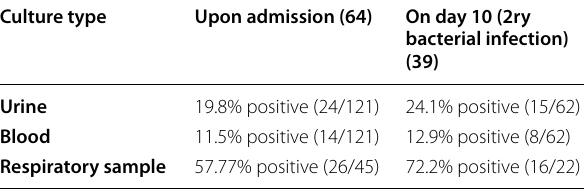
Table 5 Results of cultures of (blood, respiratory sample, urine) of patients upon admission to the ICU and on day 10 of ICU